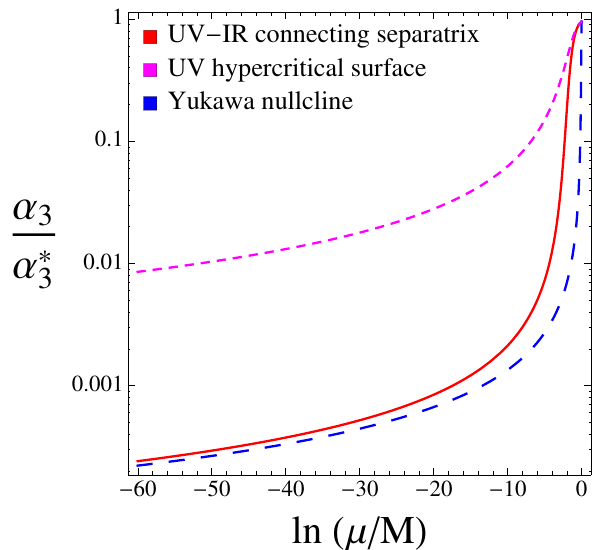
Figure 23 . UV-IR connecting trajectories at the example of a partially interacting (cid:12)xed point FP 3 and parameters R 2 = 1 , R 3 = 10 , N F = 30, showing the exact separatrix (red line) in comparison with the UV hypercritical surface approximation (magenta), (A.13), and the Yukawa nullcline approximation (blue), (A.22). The Yukawa nullcline o(cid:11)ers a good global approximation for the exact UV-IR connecting